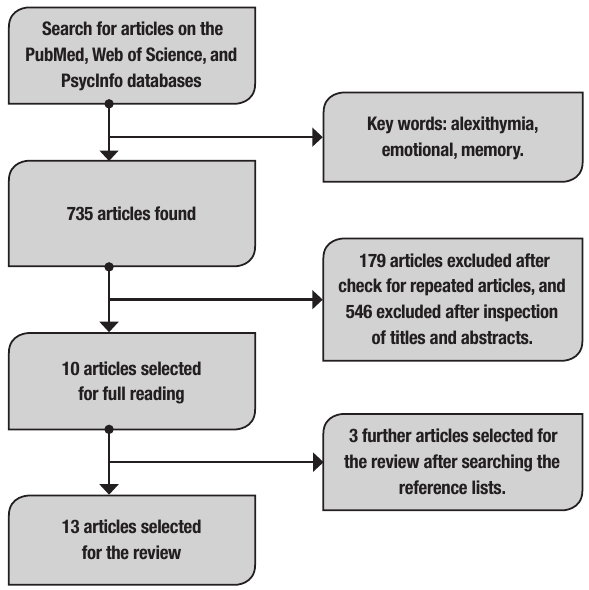
Figure 1. Flowchart describing the steps of the selection of articles for the